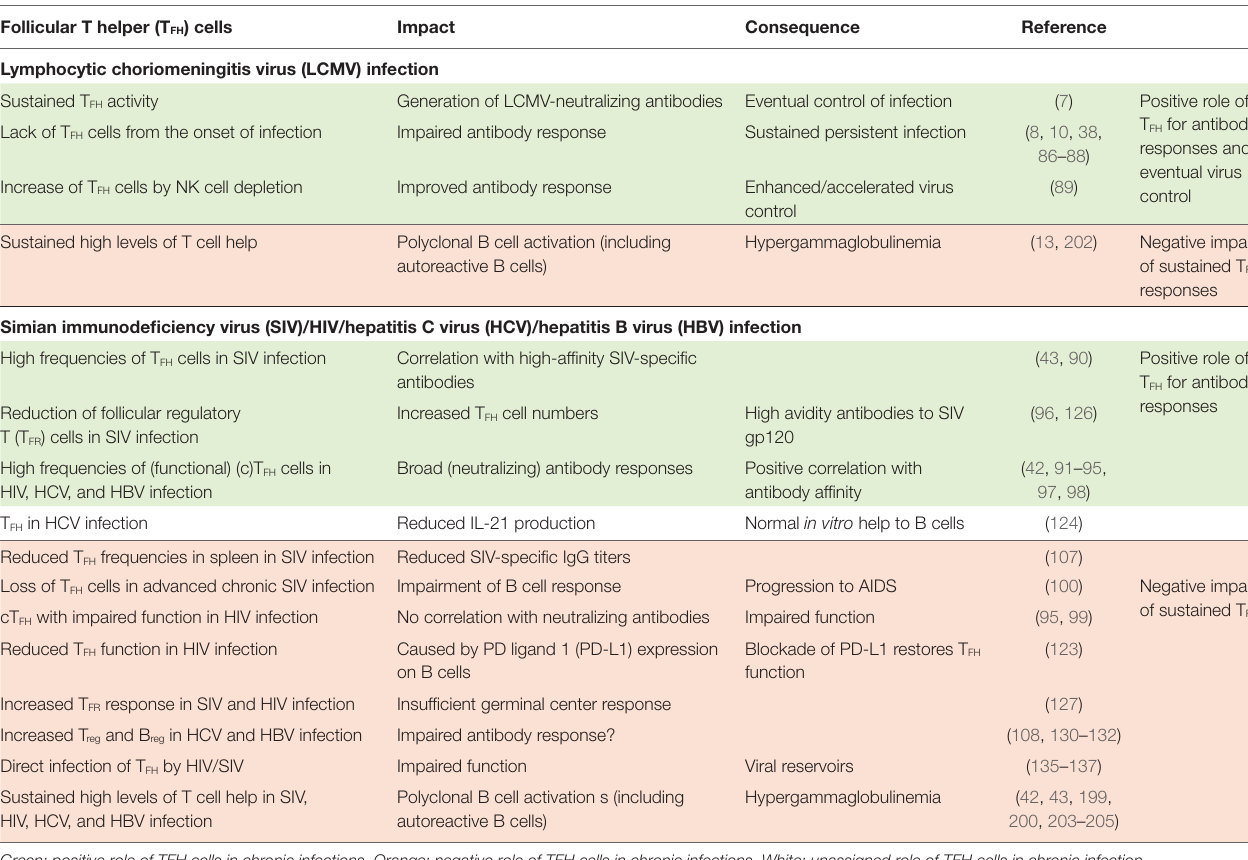
Table 1 | Regulation and role of T FH cells in chronic viral